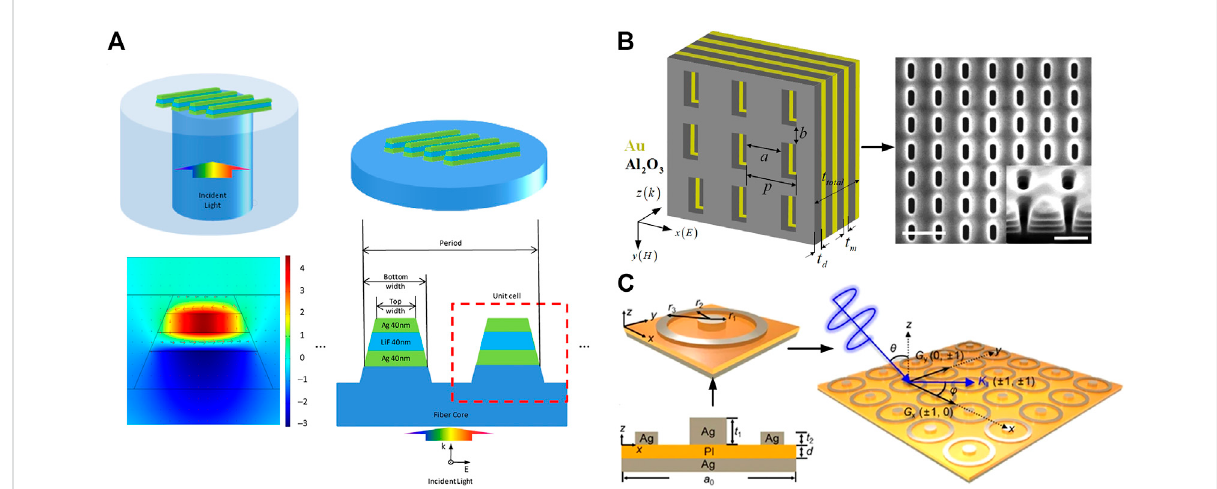
FIGURE 1 (A) A fi ber-coupled magnetic metamaterial structure schematically [12]. (B) Schematic diagram of a fi shnet metamaterial made of metal- dielectric multilayer stack and top scanning electron microscope image of its structure. The scale bars are 1 µm and 500 nm, respectively [13]. (C) Schematic diagram and surface plasmon polariton excitation of the dual-band perfect absorber. The Metal – insulator – metal structure is composed ofAgandpolyimide(PI)layershavingthicknessesof t 1 , t 2 ,and d ,and a unitcellperiodof a 0 .Unitcellofthecircularring-diskstructure,wherethe disk radius is r 1 and the inner and outer radii of the ring are r 2 and r 3 , respectively. Incident light (red line) with polar angle θ encounters a 2D array consistingofcircularmetaldisksandrings.The fi rstBrillouinzoneisde fi nedbyconnectingtheperpendicularbisectorsofthereciprocallattice,anda portion of the incident light propagates in the plane containing the periodic pattern with azimuthal angle φ